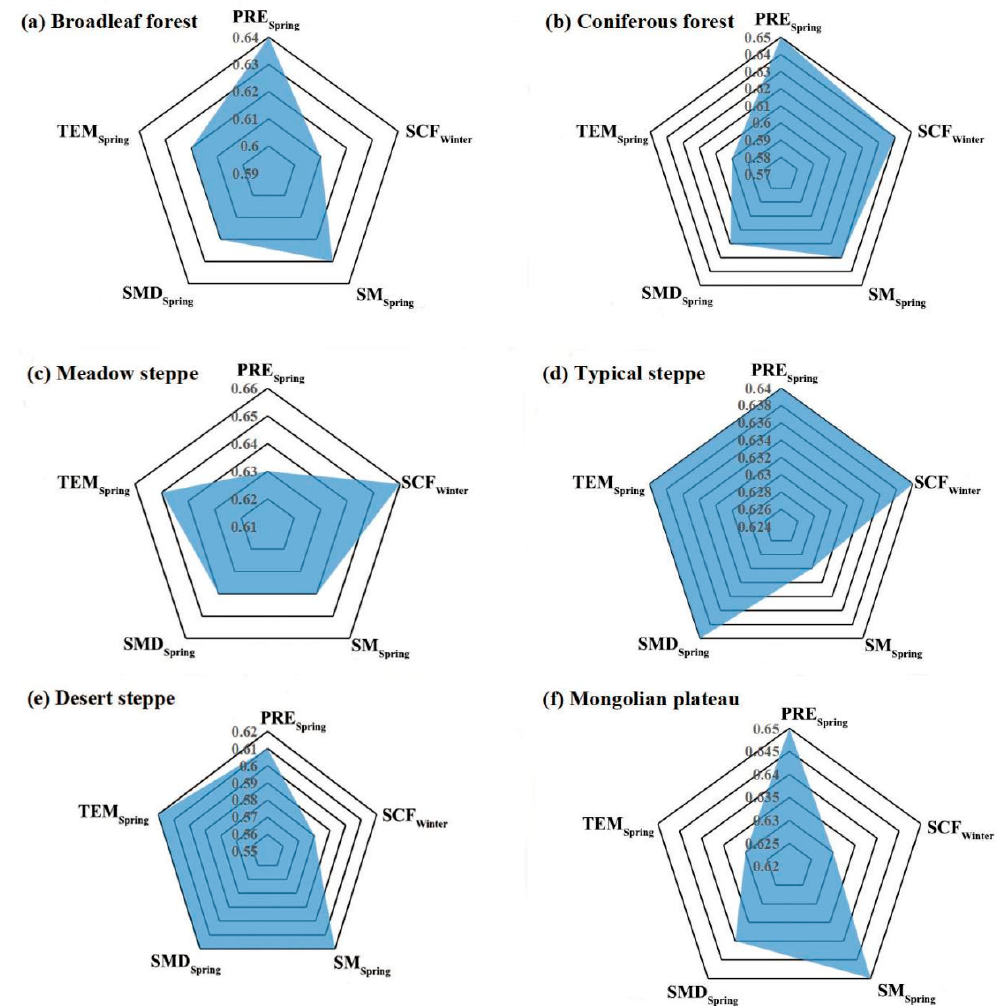
Figure 5. Different vegetation types of 2001–2019 grey relation grade of SOS NPP .